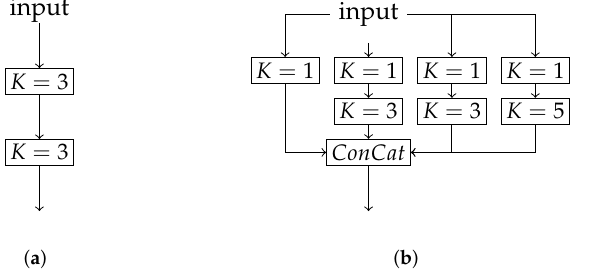
Figure 2. Double convolution and adapted inception module for U-Net. One filter branch with a Kernel of K = 3 is dilated by D = 2. Batch normalization and ReLu as the activation function is used after each convolution. ( a ) Regular U-Net; ( b ) Adapted inception module.